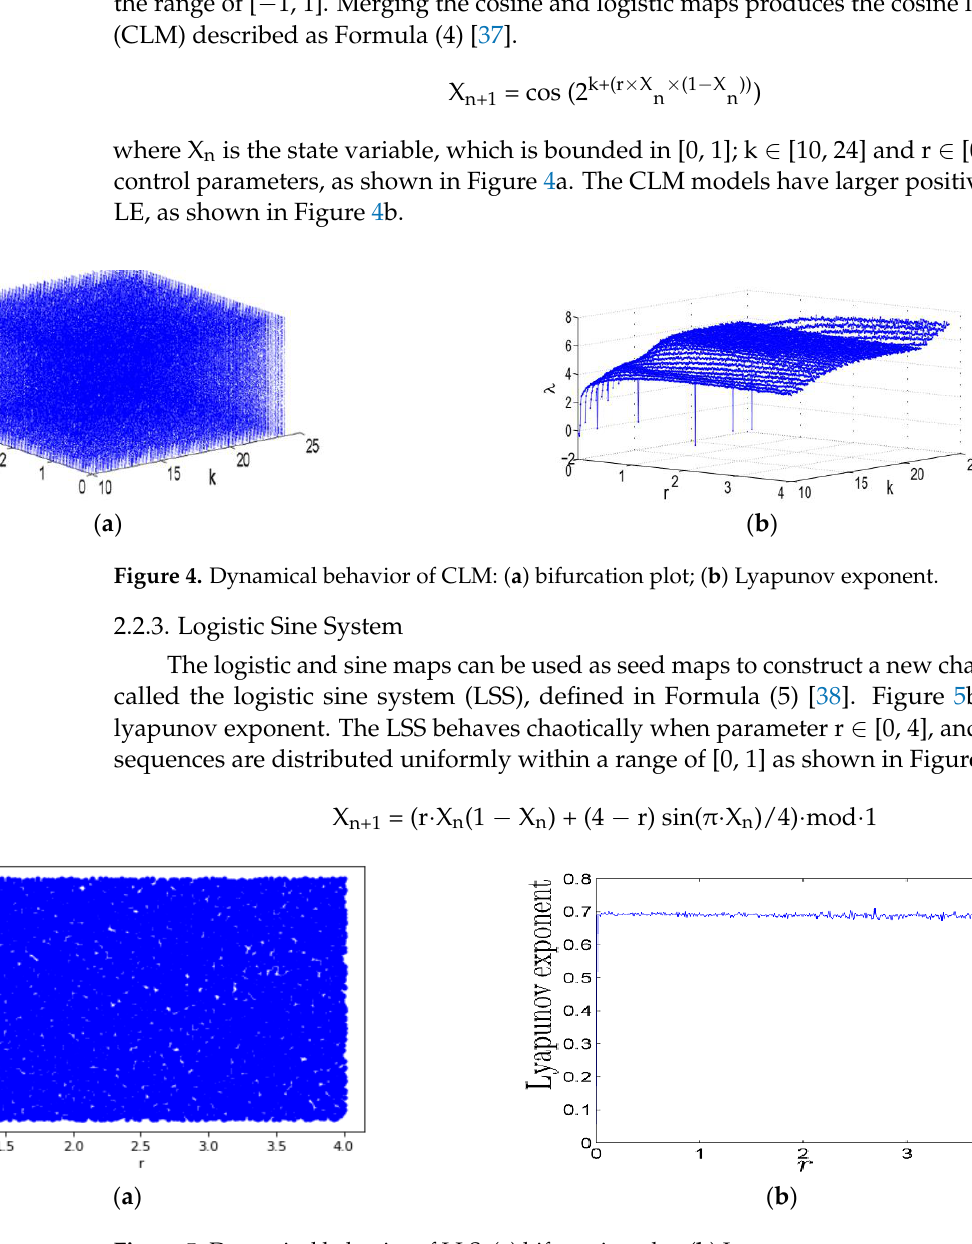
Figure 5. Dynamical behavior of LLS: ( a ) bifurcation plot; ( b ) Lyapunov exponent.